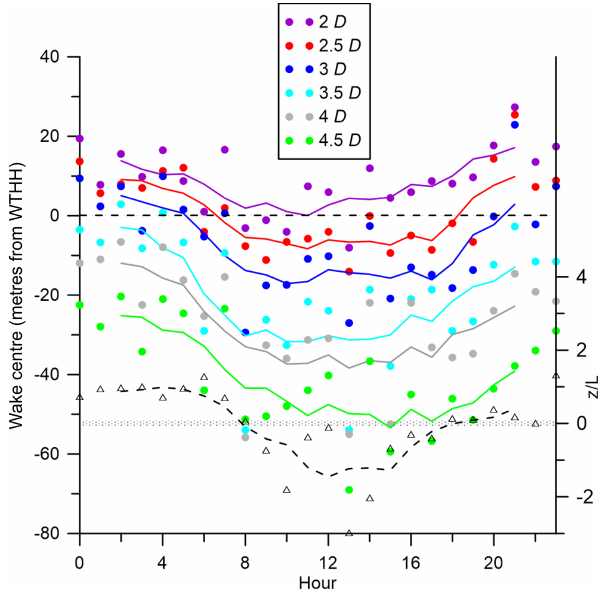
Figure 15. Mean vertical location of the wake centre by hour of the day (A type only) for different distances (2–4.5 D) downstream from the wind turbine location. Coloured dots show the height of the centre relative to the wind turbine hub height (WTHH – the dashed line at 0m), and the lines depict a five-point running mean for each downstream distance. Also shown is the median value for z/L for each hour (black line and open triangles), with near-neutral conditions being indicated by the shaded bar (right-hand